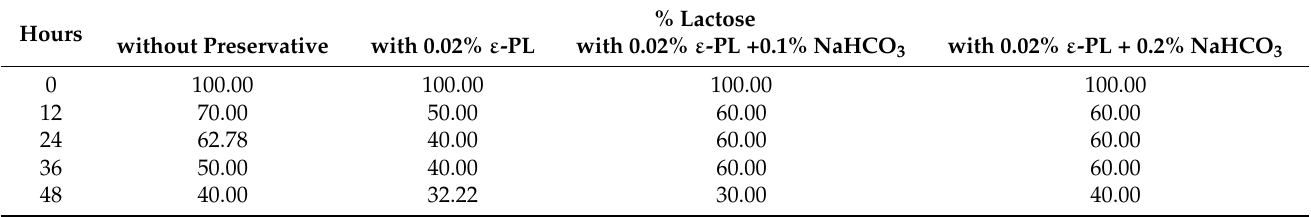
Table 6. Effect of ε -PL and sodium bicarbonate as the preservative on lactose degradation.